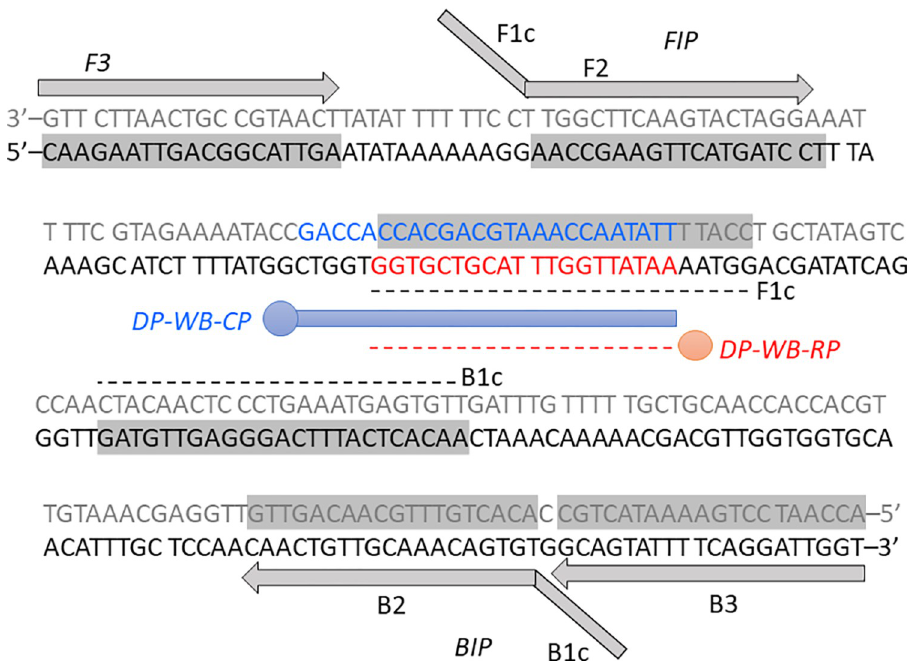
Fig 1. Schematic diagram demonstrates the LAMP primers and probe binding locations on the target sequence of the w AlbB wsp gene. Grey boxes indicate the primer sequences. Grey letters are the complementary sequence of the w AlbB sequence in the 5 0 -3 0 direction. Blue and red fonts indicate the capture and reporter probes, respectively.